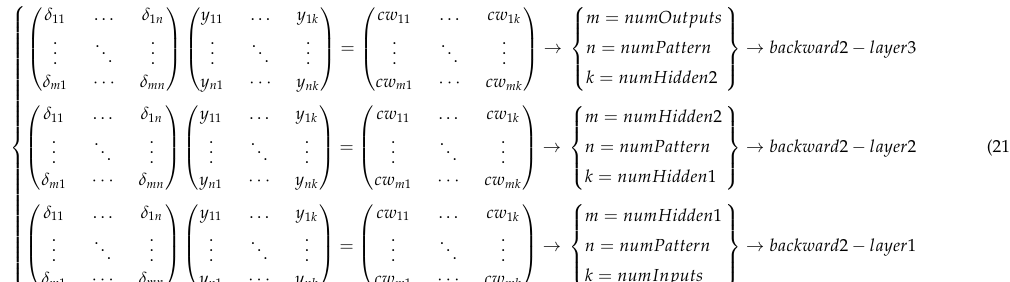
B : n rows k columnsoftiles